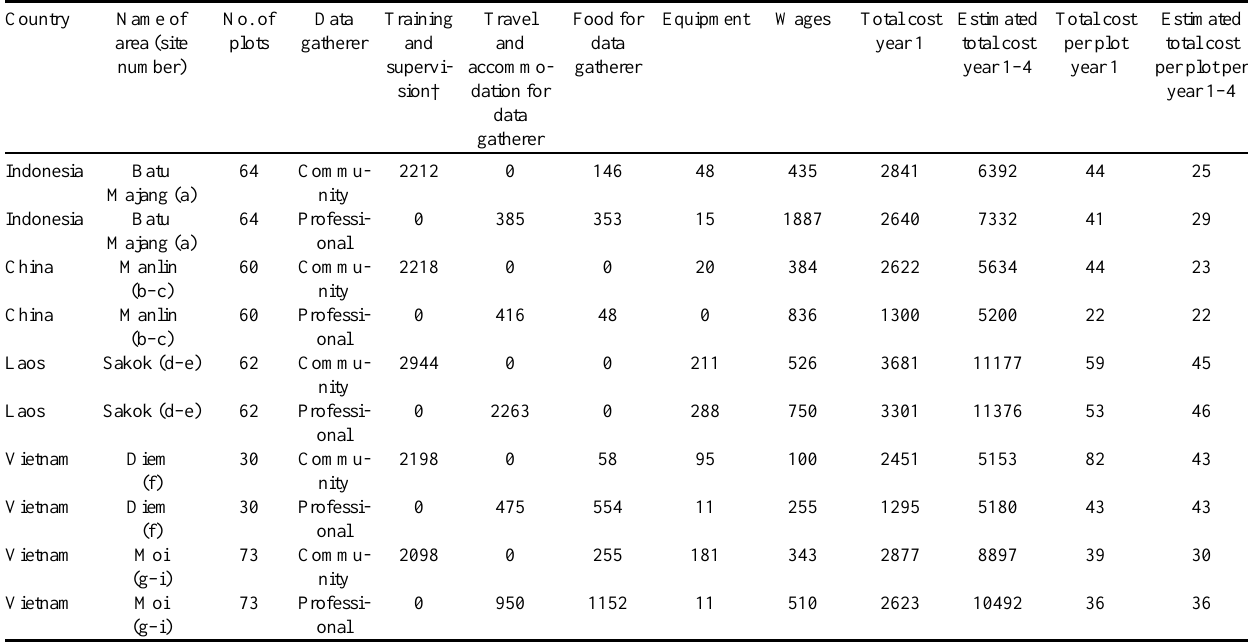
Table 2 . Cost of community and professional forester-executed measurements of biomass in the study areas in Indonesia, China, Laos, and Vietnam (details in Appendix 3). All costs are in US$.